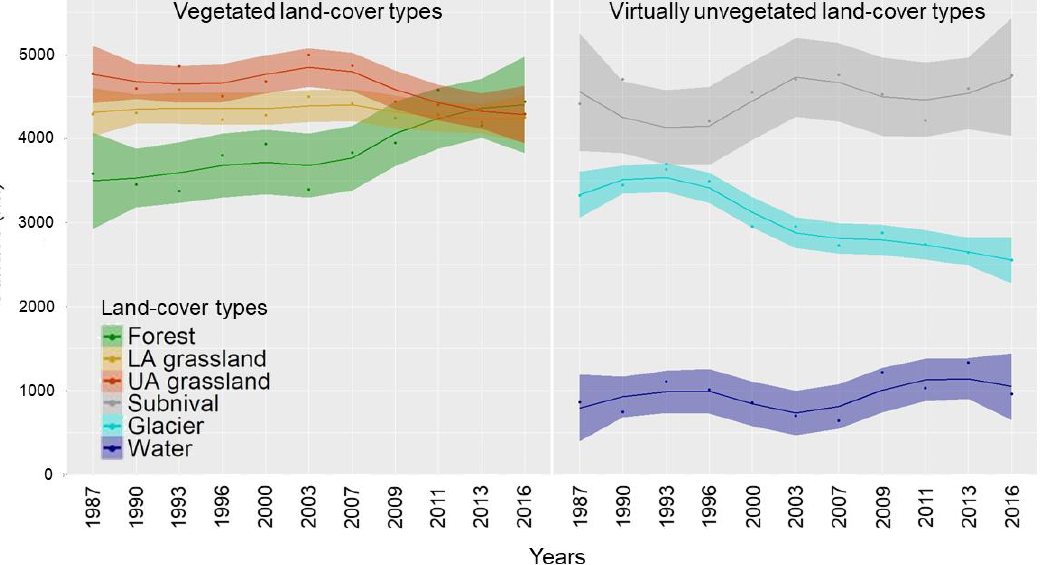
Figure 5. Magnitude of changes in the occupied surfaces estimated for the six land-cover types over the last thirty years. The ( a) absolute (hectares) and ( b ) relative (percentage) magnitude values were estimated subtracting sums of fuzzy mem- bership values in 1987 from those of the 2016 time window. Magnitude values for each type are delimited by a white line, whereas increasing and decreasing values are delimited by the vertical black line.